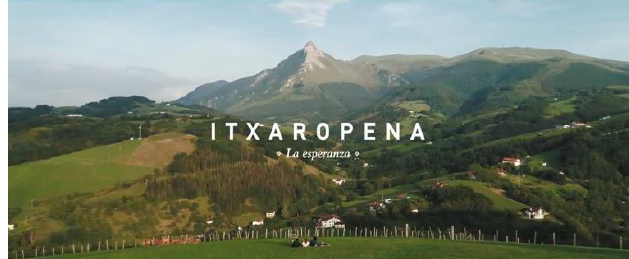
Figure 3. Capture of the “Itxaropena” campaign.